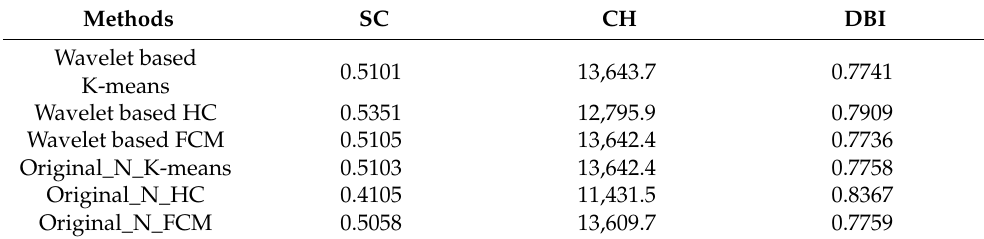
Table 2. Clustering evaluation comparison results of the proposed